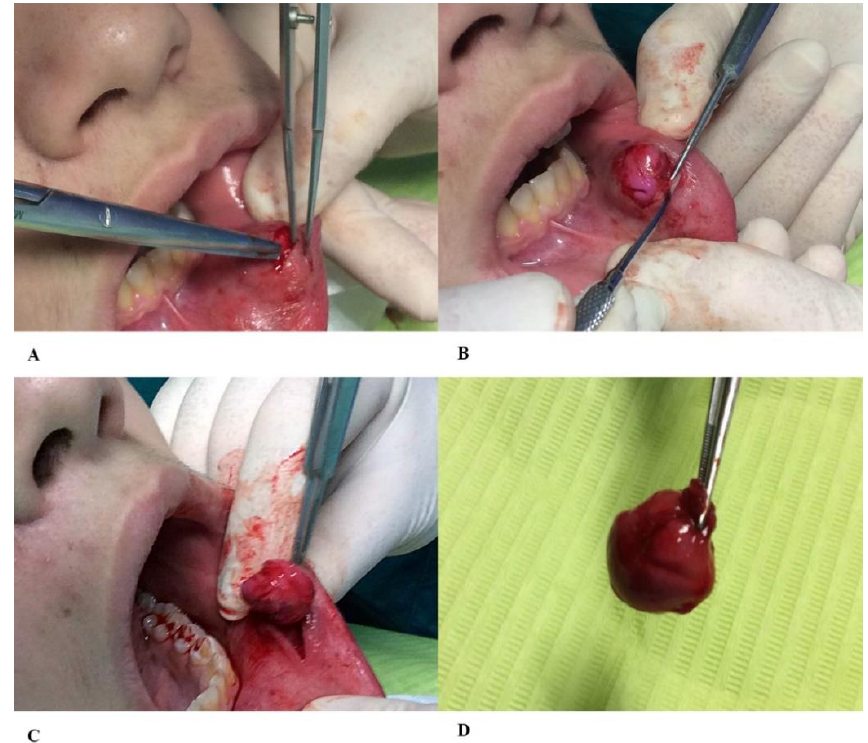
Figure 3. ( A ) After insertion into the lumen of the hydrocolloid material injury impression, we proceeded with the dissection of the flap through scissors with rounded ends and ( B ) the removal of the cyst wall, ( C ) preserving the healthy surrounding tissue. ( D ) The complete removal of the cyst wall is the key to preventing recurrence of